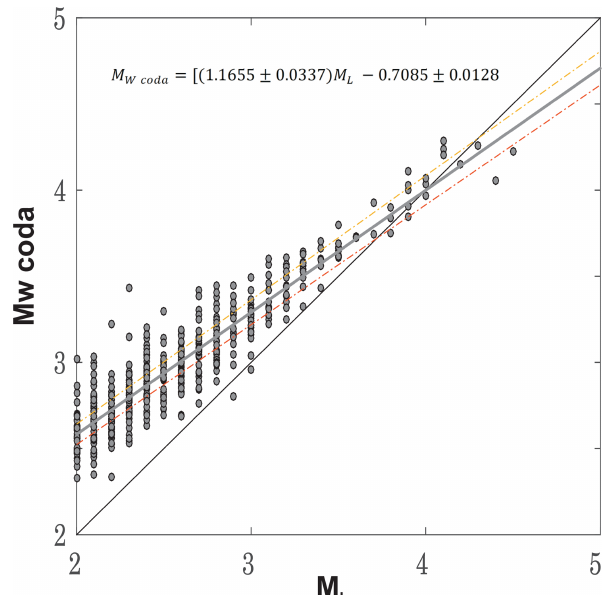
Figure 6. Scatter plot between local magnitudes ( M L ) of analyzed events with coda-wave-derived magnitudes ( M w coda) of the same events. The outcome of a linear regression analysis yielded an em- pirical formula (e.g., Eq. 10) to identify the overall agreement repre- sented by the gray straight line. Yellow and red dashed lines indicate the upper and lower limit of linearly fitting to that scatter.